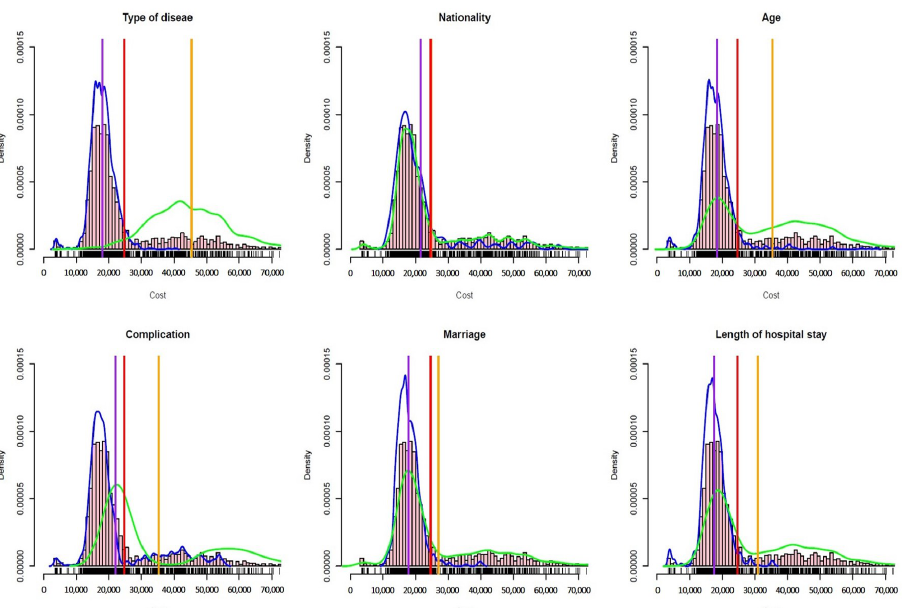
Figure 1. Grouping based on different features. The blue and green curves represent the density of the distribution of different case subgroups, and the purple and orange lines represent the average cost of the corresponding subgroups. The red line represents the average cost before